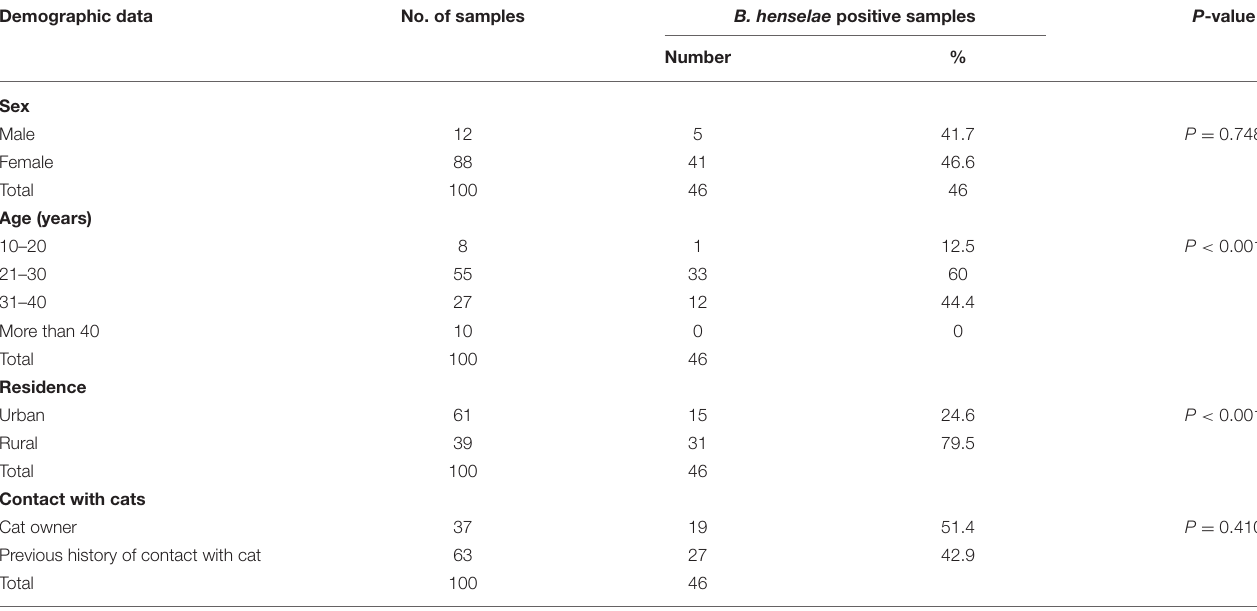
TABLE 2 | Seroprevalence and epidemiological data associated with the occurrence of Bartonella henselae ( B. henselae ) infection in humans. Demographic data